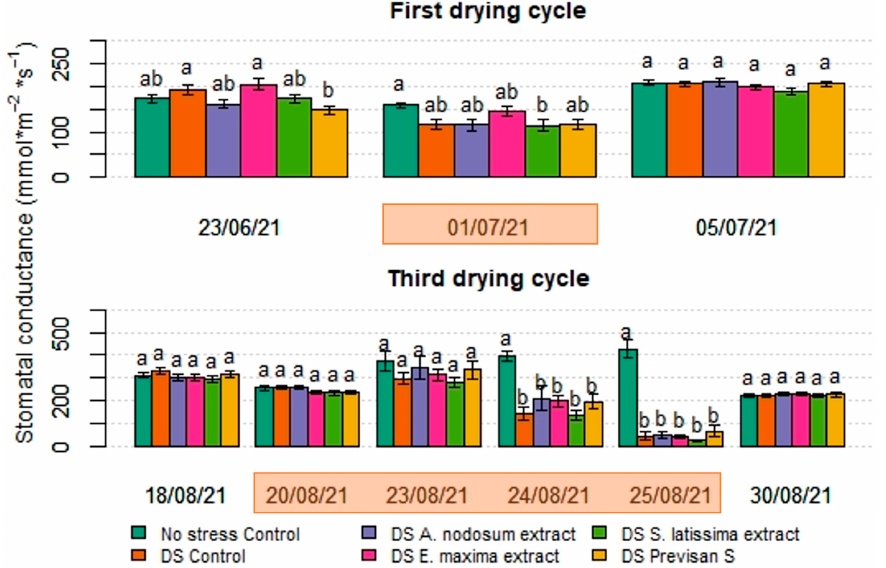
Figure 3. Effect of drying cycles without (DS Control) and with biostimulant treatments on the stom- atal conductance of Hydrangea , compared with optimal irrigation (No stress Control). Highlighted dates indicate stress period. Data were analyzed by a two-way ANOVA followed by a Tukey HSD test, except for data on 23 June 2021, 24 August 2021, and 25 May 2021. These results were analyzed by a Scheirer–Ray–Hare test followed by a Dunn’s test. Different letters (a and b) per measurement day indicate significant differences at p ≤ 0.05 (Mean ± SE, n = 16).